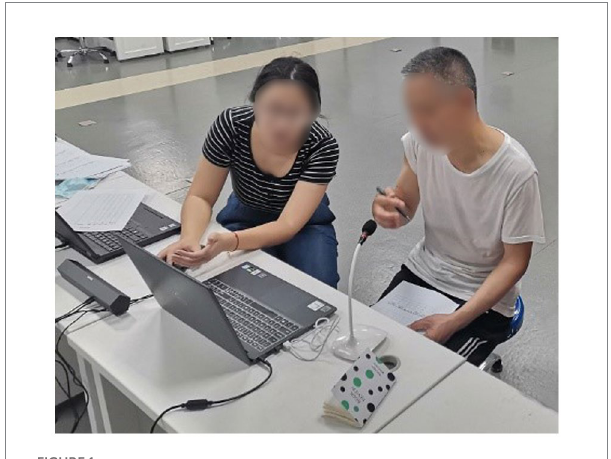
FIGURE 1 Environment for voice interaction